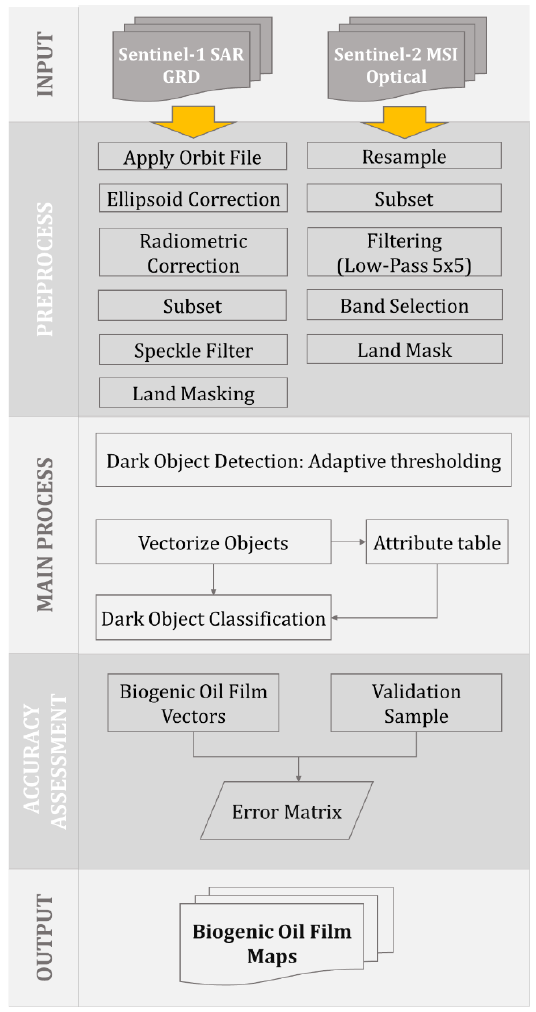
Figure 3. Flowchart of the development methodology.